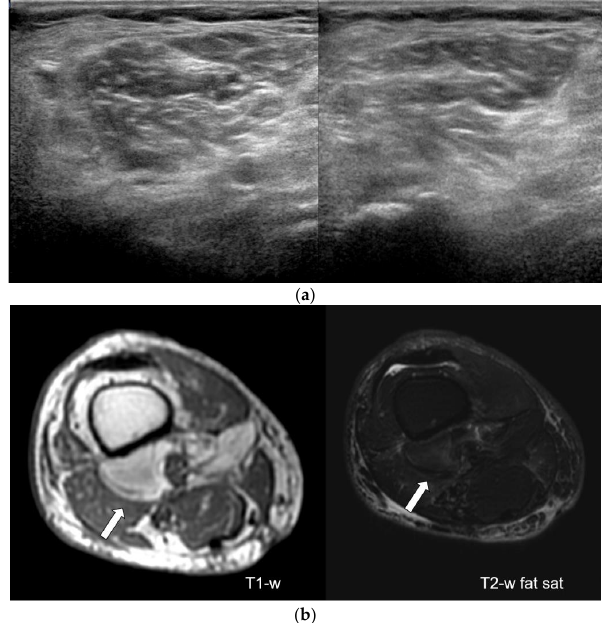
Figure 2. A 78-year-old man operated for a localized liposarcoma of the popliteal fossa in follow-up ultrasound images ( a ) obtained at the popliteal fossa were reported as negative for local recurrence with no recurrence demonstrated in the follow-up. MRI images ( b ) show a deep-located (white arrow) nodular lesion with MRI signal consistent with fat on T1-weighted sequences and T2-weighted sequences with fat saturation. A slight hyperintensity on T2-weighted sequences with fat saturation was present. In this case, ultrasound was reported negative for recurrence, whereas MRI was reported positive.